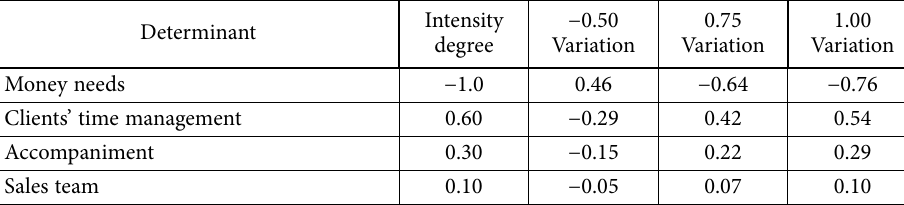
Table 6. Analysis of operational management